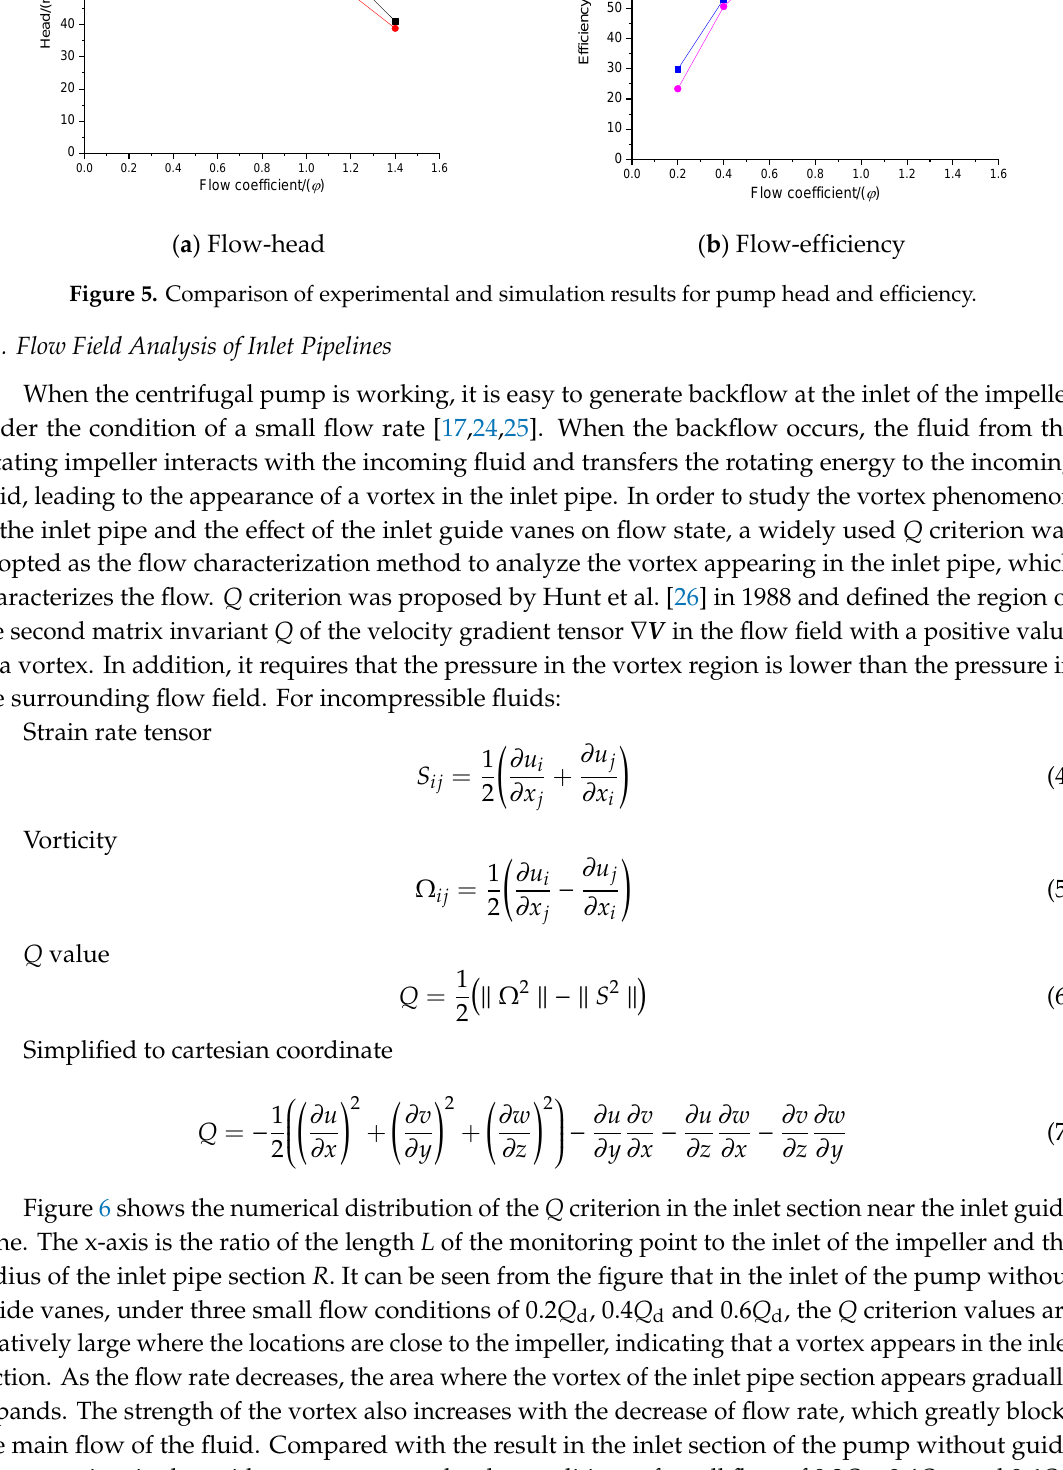
Figure 4. The scheme of the test rig.